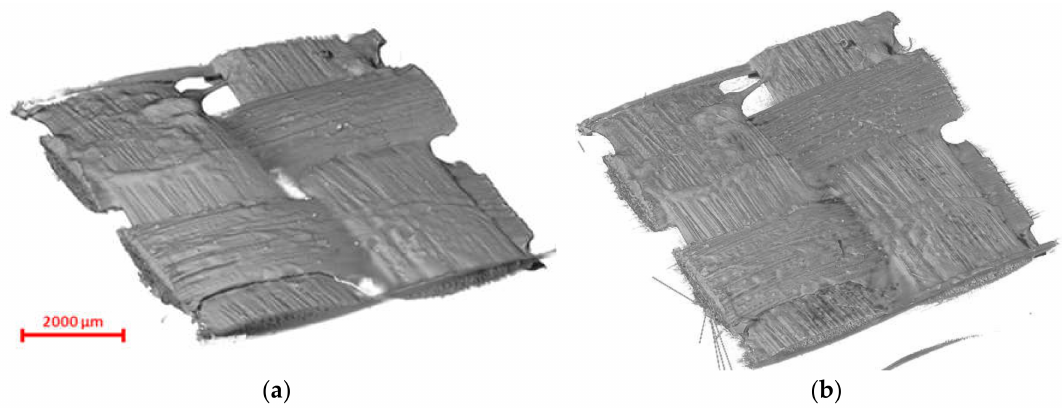
Figure9. Three-dimensionalrenderingoftheprepregsample( a )absorptioncontrastand( b )propagation phase contrast. The thresholding range of 133–182 was used to represent carbon fibers after normalizing the histogram for both cases.